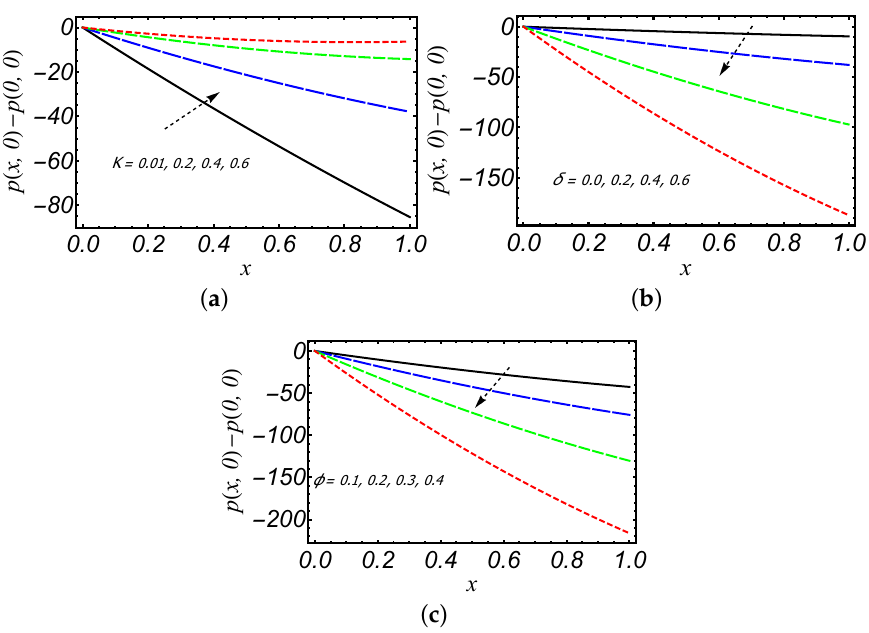
Figure 10. Behavior of p ( x ,0 ) − p ( 0,0 ) due to ( a ) K when φ = δ = 0.2, ( b ) δ when K = δ = 0.2, ( c ) φ when K = δ = 0.2.